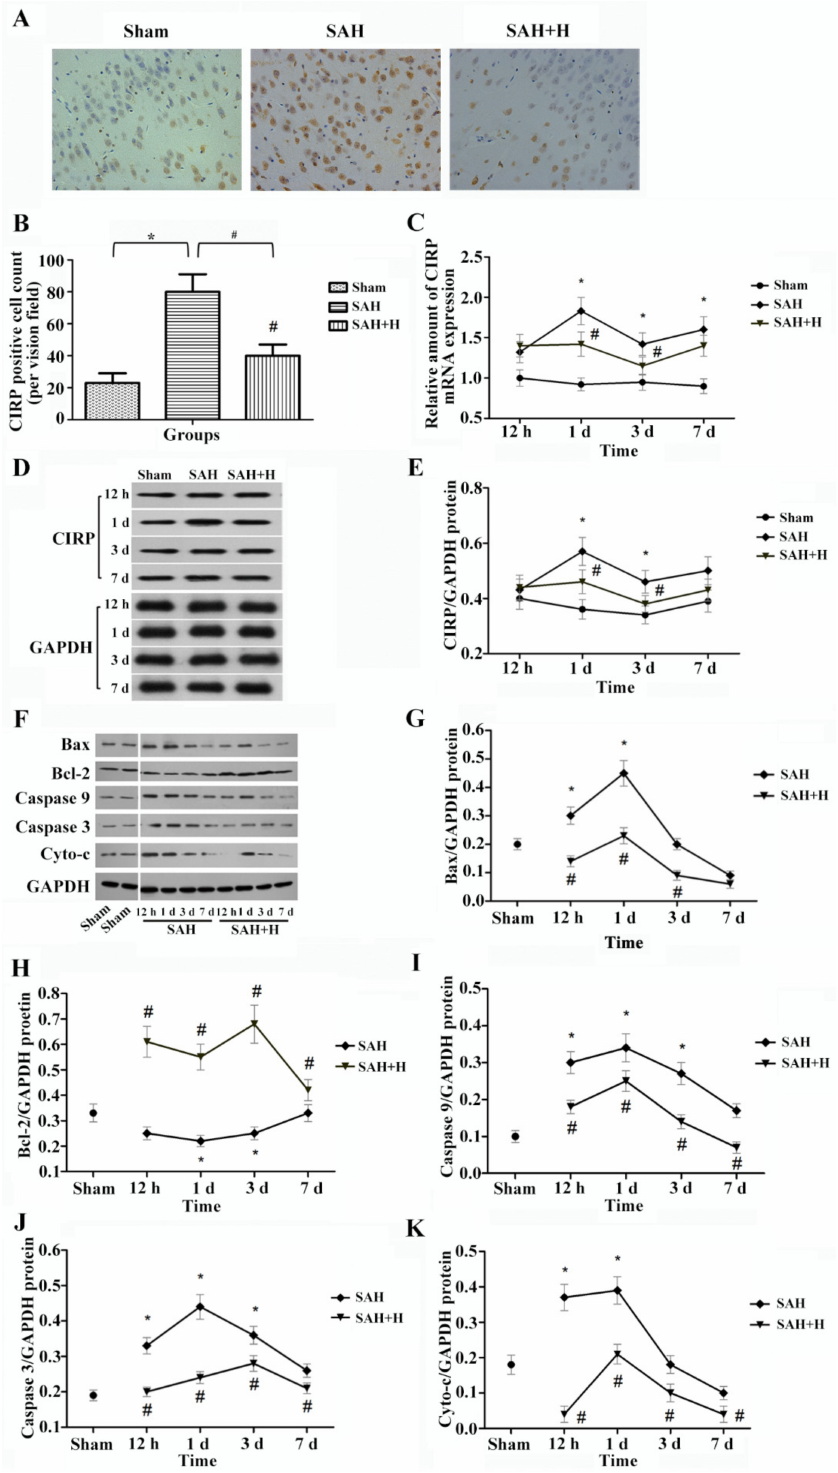
Figure 5. The analysis of CIRP mRNA and protein expression and mitochondrial apoptosis pathway- related proteins from 12 h to 7 d after SAH. ( A , B ) Immunohistochemical results of rat brain tissue ( × 400) 1 d after SAH. ( C – E ) Expression levels of CIRP mRNA and protein at four time points. ( C ) Analysis of CIRP mRNA at four time points by RT-PCR. ( D , E ) Western blot analysis of the CIRP protein expression at four time points. ( F – K ) Expression of the mitochondrial apoptosis pathway- related proteins including Bax, Bcl-2, caspase-9, caspase-3, and cytochrome c. * p < 0.05 SAH vs. Sham; # p < 0.05 SAH+H vs.